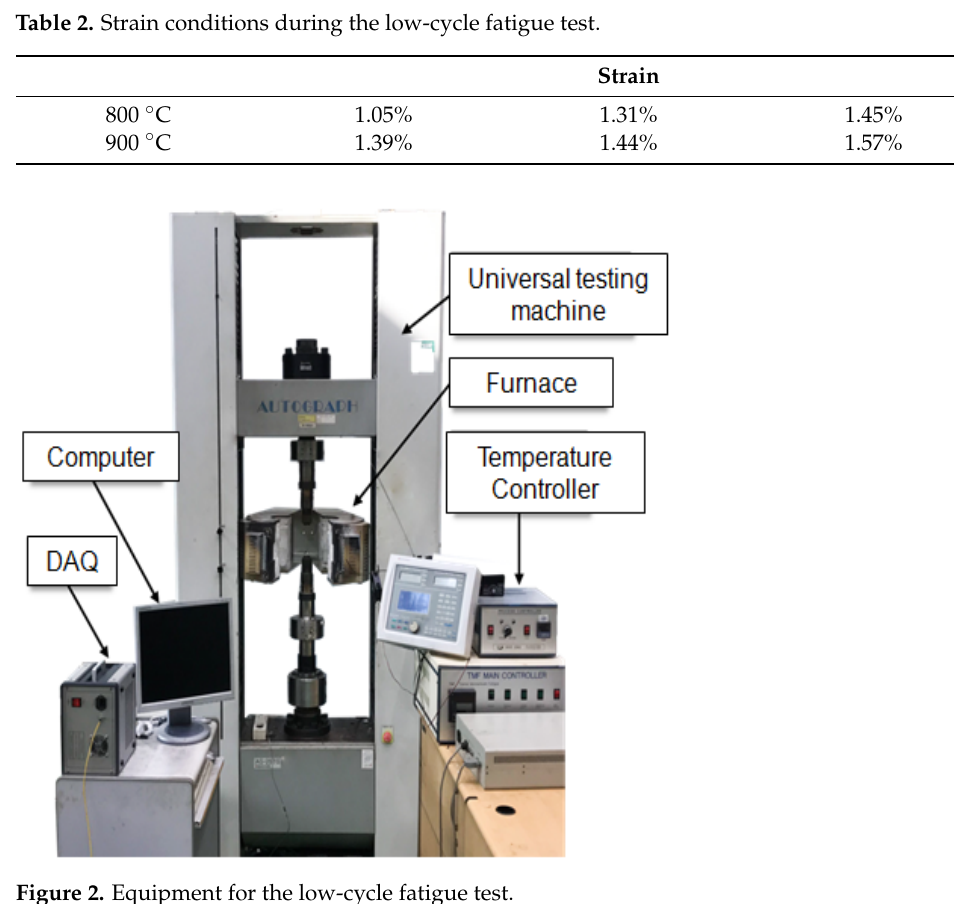
Figure 2. Equipment for the low-cycle fatigue